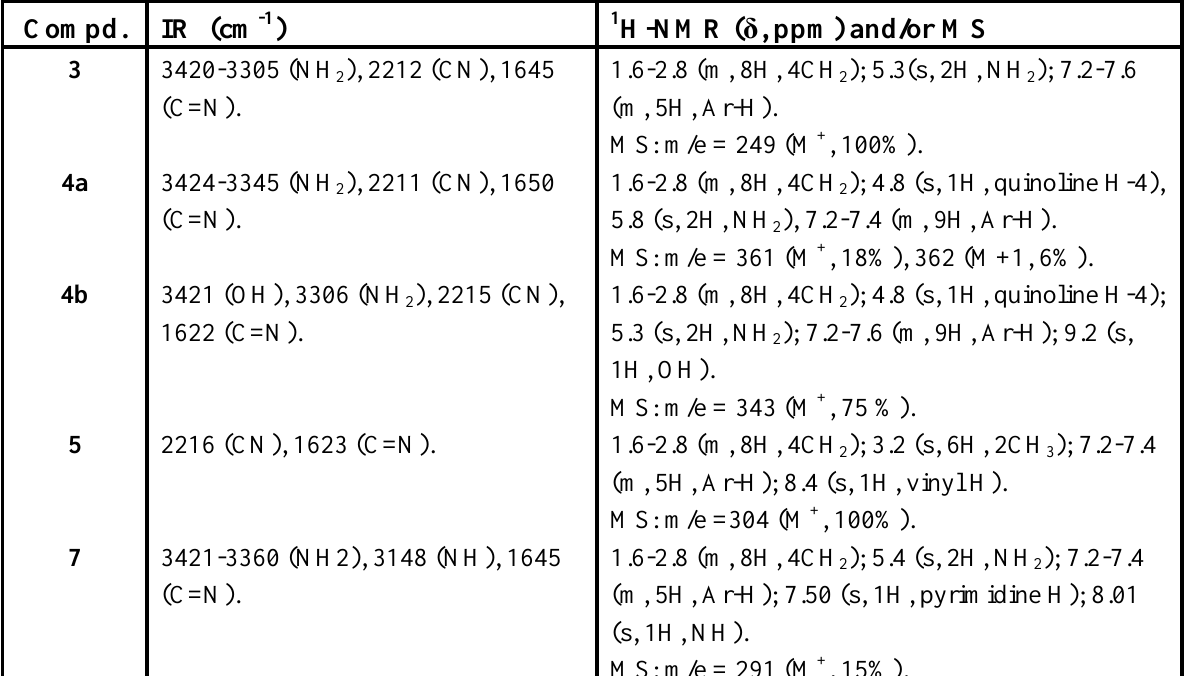
Table 5. IR, 1 H-NMR, and MS of the new